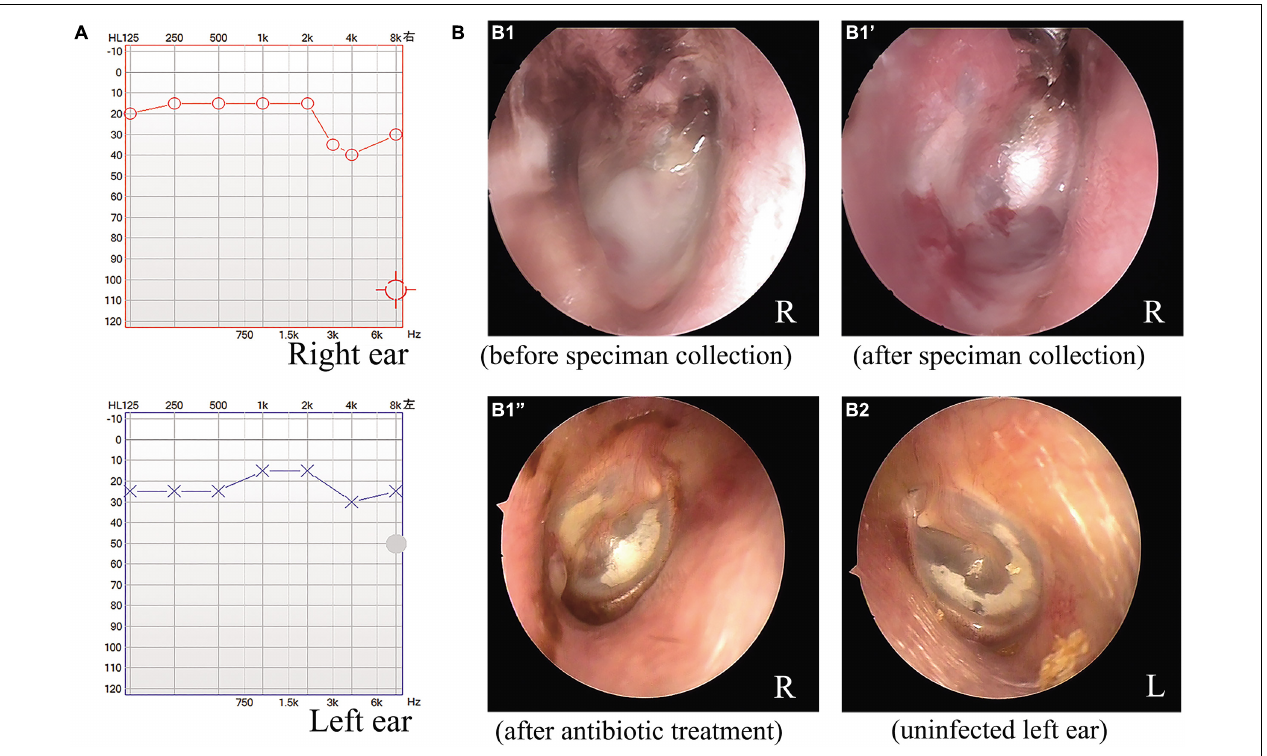
FIGURE 1 | Audiometric and otoscopic examination of a patient with a chronic ear infection. The audiometric evaluation indicated mild hearing impairment associated with the chronic ear infection of the patient (A) . Otoscopic examination of the right ear of the patient before (B1) and after microbiological specimen collection (B1 (cid:48) ) and after antimicrobial treatment (B1 (cid:48)(cid:48) ) . Otoscopic view of the uninfected left ear of the patient after antimicrobial treatment for the right ear (B2) .